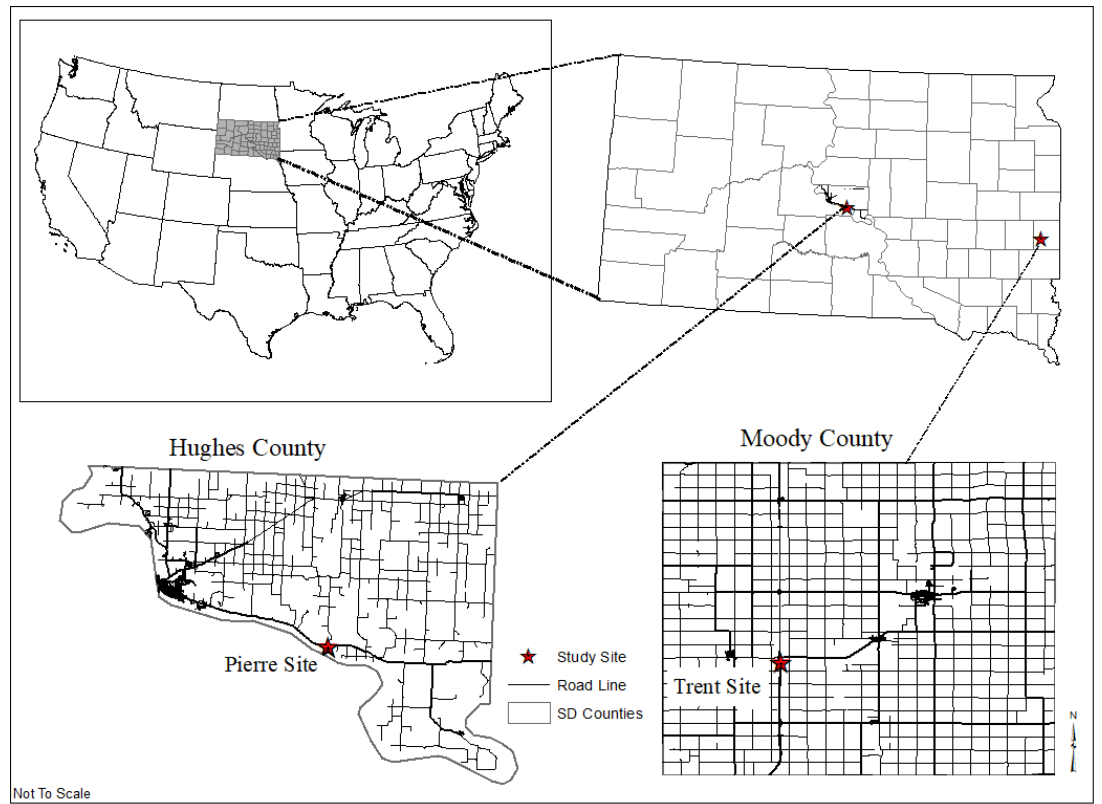
Figure 1. Sites for nutrient and metal leaching study in roadside ditches in South Dakota.